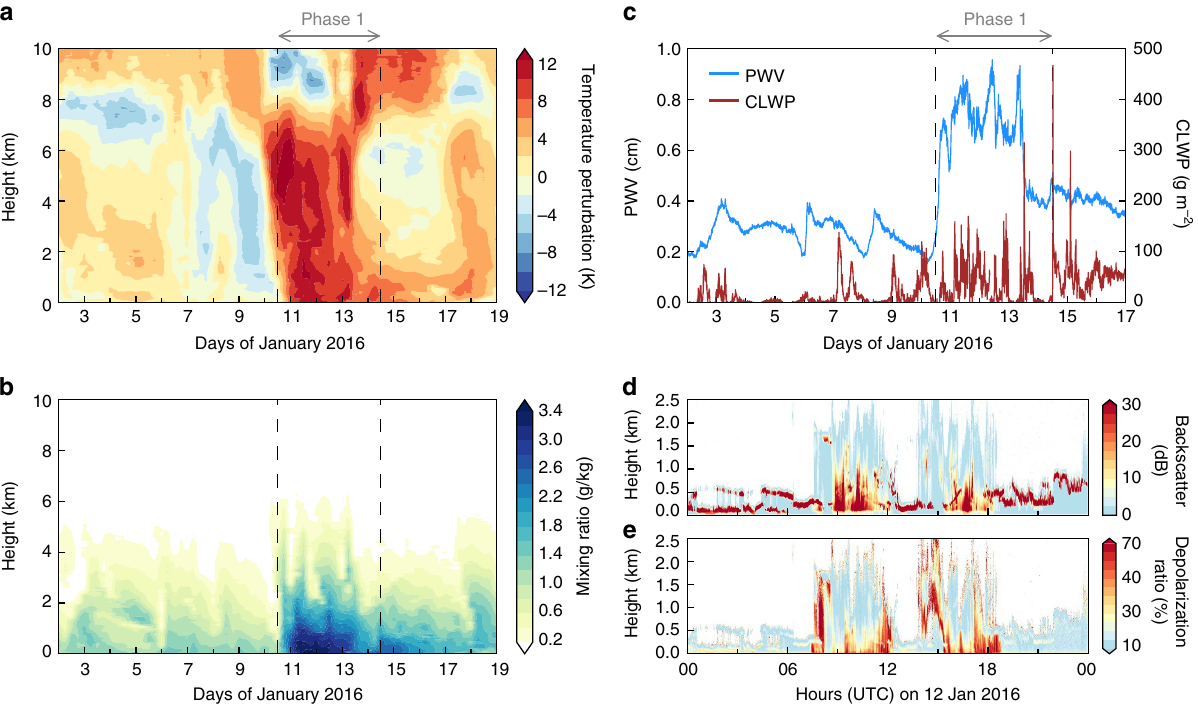
Figure 3 | Cloud, moisture and temperature observations at WAIS Divide during January 2016. ( a , b ) Vertical profiles of temperature perturbation and water vapour mixing ratio based on 6-hourly radiosoundings. The temperature perturbation is calculated as the difference between the measured temperature and the mean temperature during the period spanning 4 December 2015 to 18 January 2016 (duration of the field campaign). ( c ) Precipitable water vapour (PWV) and cloud liquid water path (CLWP) estimated from microwave radiometer measurements. ( d , e ) Vertical profiles of attenuated backscatter and depolarization ratio based on micropulse lidar measurements from 12 January 2016. For all vertical profiles, the height is with respect to the ground level (1,801m above sea